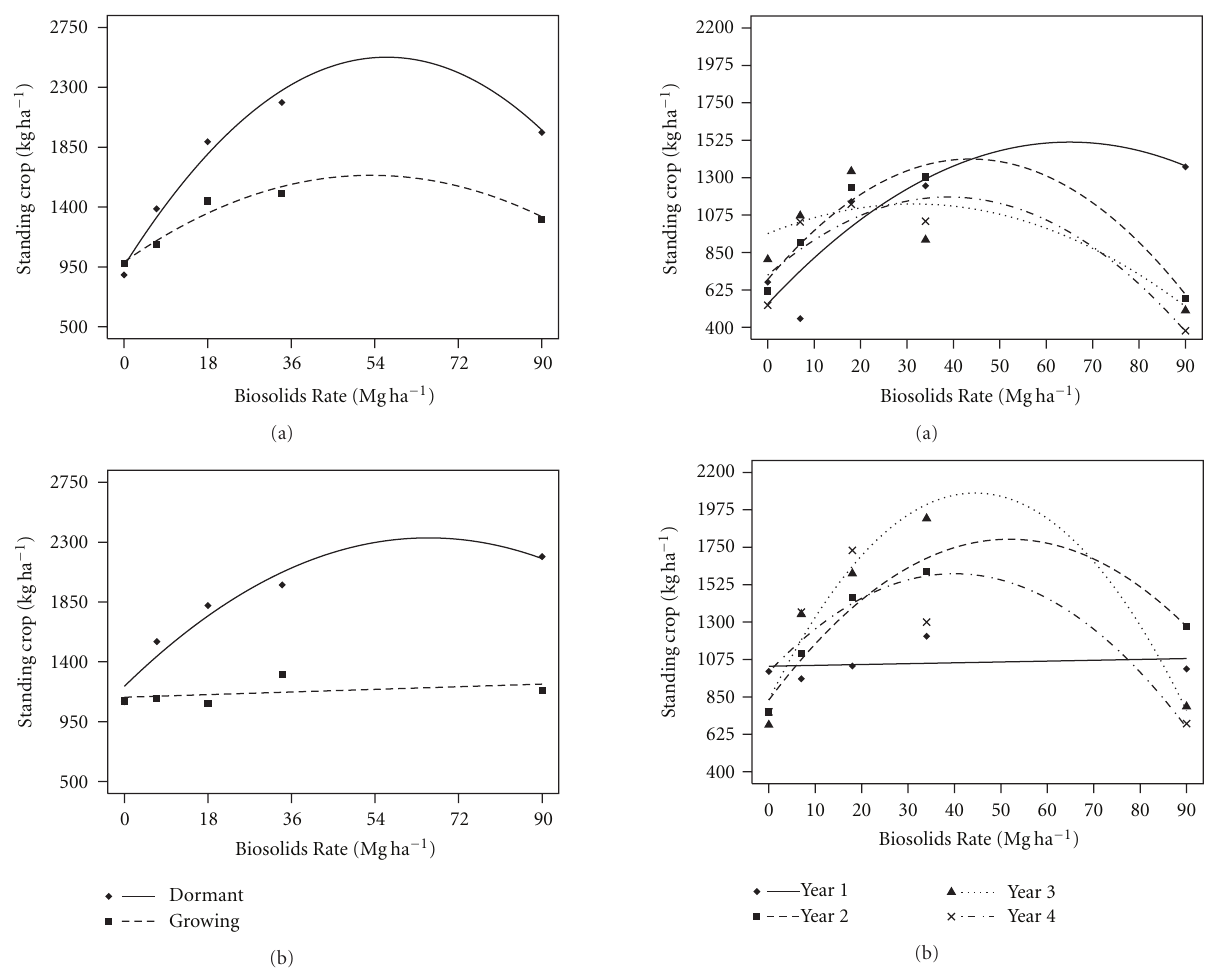
Figure 1: Standing crop (kgha − 1 ) at the end of the 1993 growing season of (a) Hilaria mutica and (b) Sporobolus airoides as a ff ected by season (dormant or growing) and rate of biosolids application (redrawn from [7]).